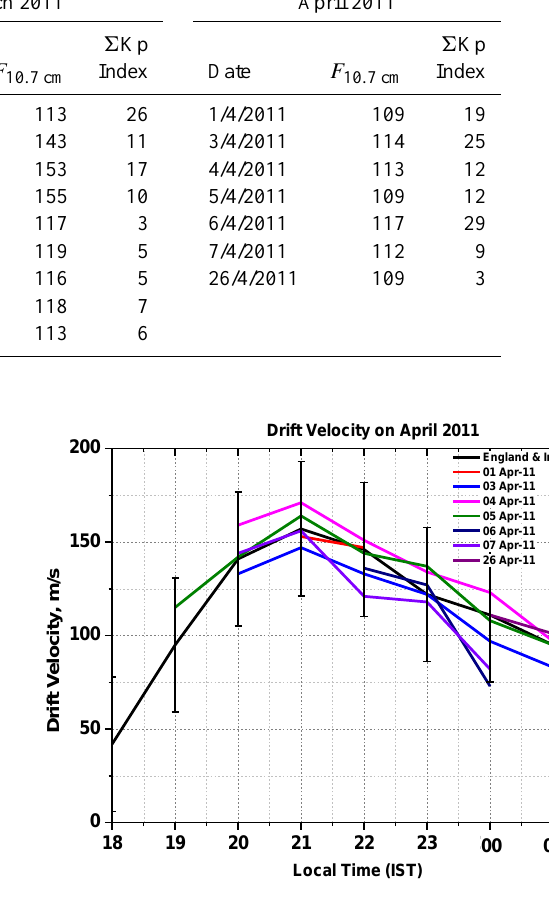
Fig. 6. The daily mean zonal drift velocities of EPBs compared with values of empirical model for the period of April 2011.